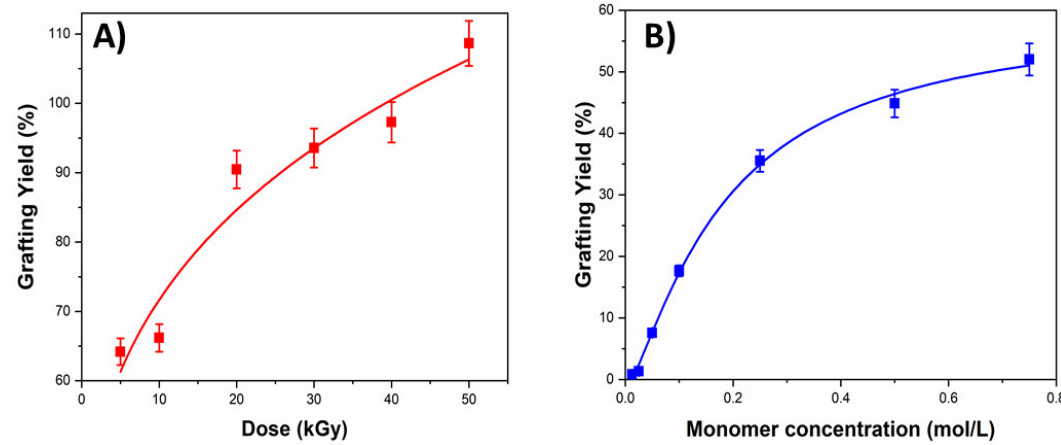
Figure 2. Grafting percentages of 2MBA onto SR- g -PNVCL films as a function of ( A ) monomer concentration and ( B ) absorbed dose.